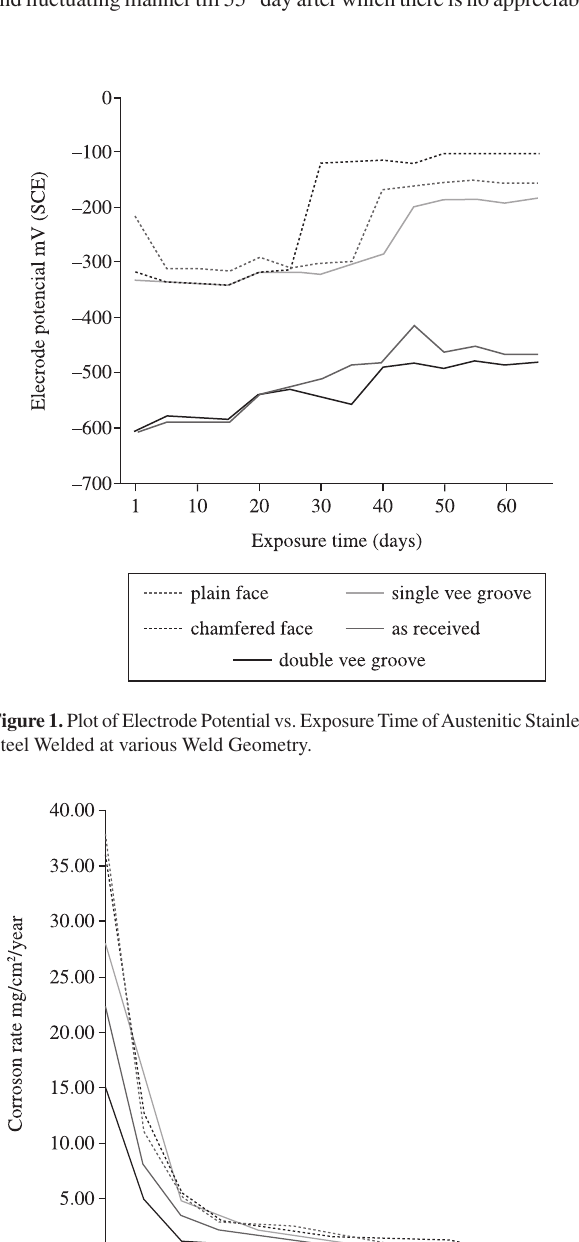
The corrosion rates for all the samples decreased rapidly